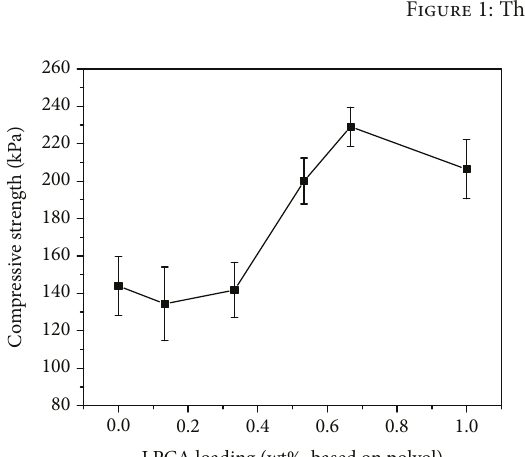
Figure 2: E ff ect of LPCAs on the compressive strength of